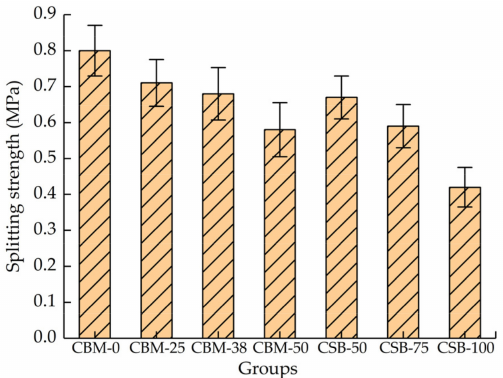
Figure 10. The splitting strength of mixture with 5% cement dosage after curing for 90 days.